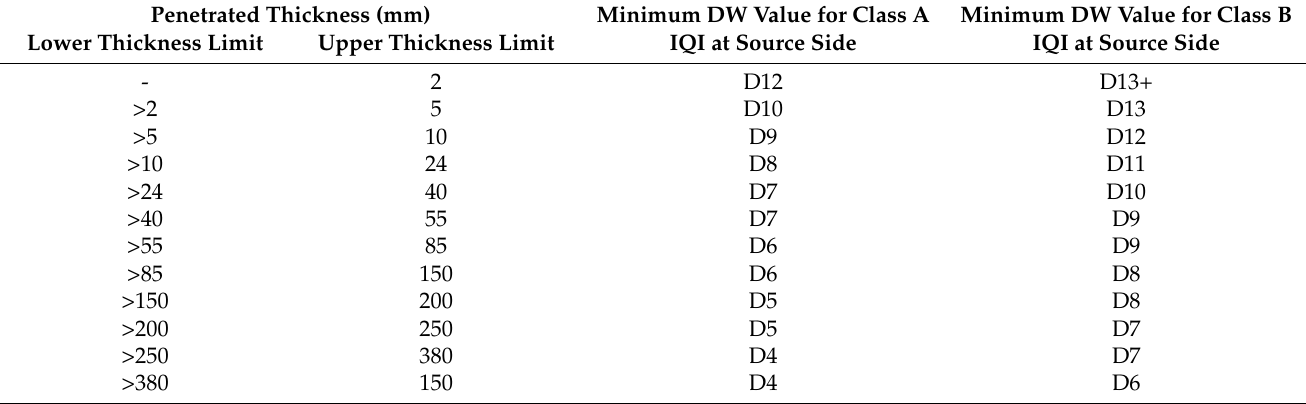
Table 3. Minimum image quality requirements for the visibility of duplex wire IQIs for class A or B.